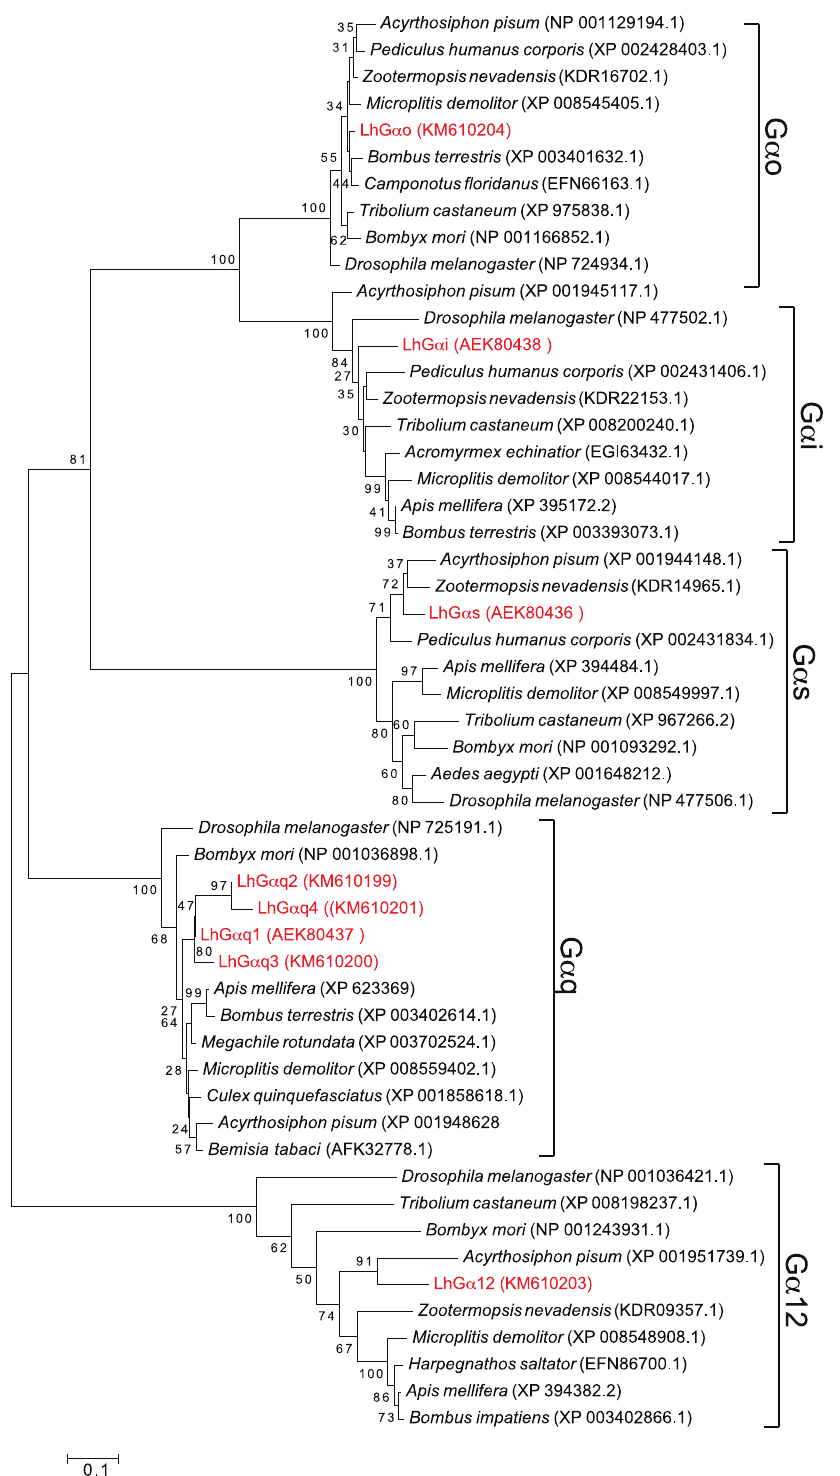
Figure 3. Phylogenetic analysis of G(cid:2) subunits from L. hesperus and other insects. Phylogenetic relationships were inferred using the maximum likelihood method based on the JTT matrix-based model [68]. The tree with the highest log likelihood is shown. L. hesperus G(cid:2) sequences are shown in